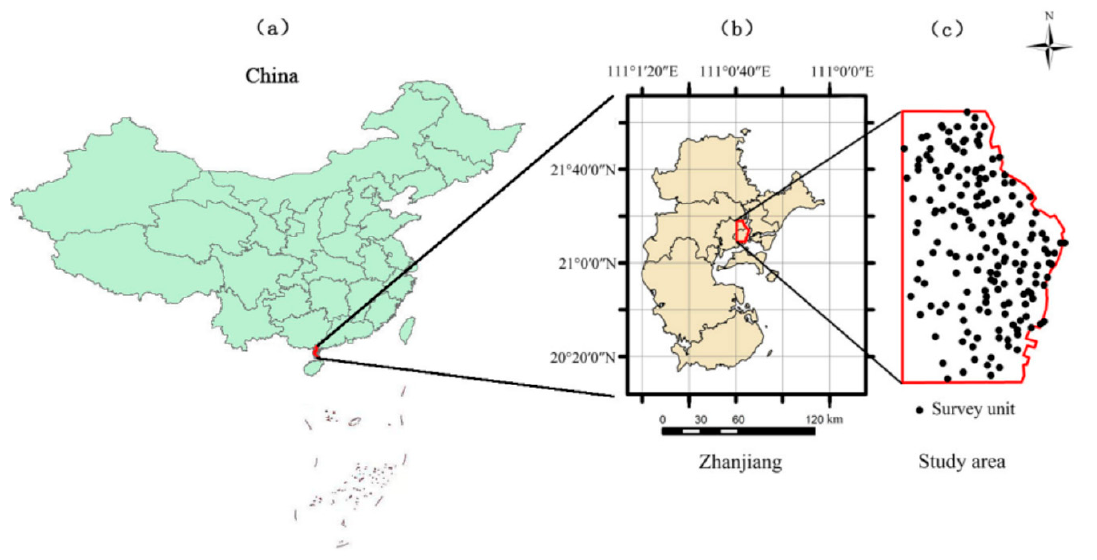
Figure 1. A map of China showing the locations of ( a ) Zhanjiang city, ( b ) the study area outlined in red, and ( c ) the field survey units within the study area indicated by black dots.